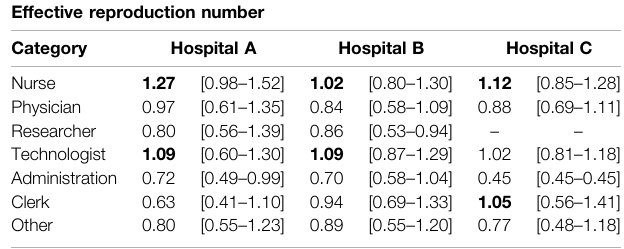
TABLE1| RiskofHCWsassessedbytheprobabilityofgettinginfected.Weshow the median and interquartile range of the relative risk for each occupational group of HCWs in the box-plot. The values in bold represent the top two high-risk categories in each hospital. Risk of getting infected